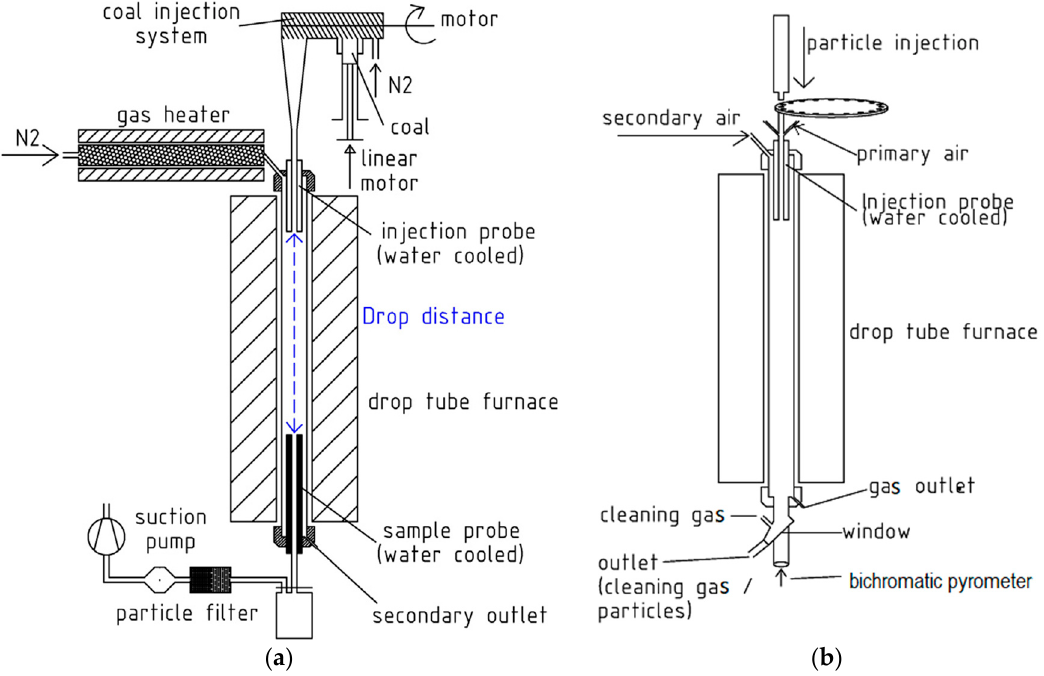
Figure 1. A schematic representation of the drop tube furnace used for the pyrolysis experiments applied to coal particles ( a ), and for the combustion of the resulting coal char particles ( b ). The silica–alumina reactor of the drop tube furnace is 1.7 m high and its radius 𝑅 (cid:3045) is equal to 3.5 cm. This reactor is placed inside a furnace whose temperature is